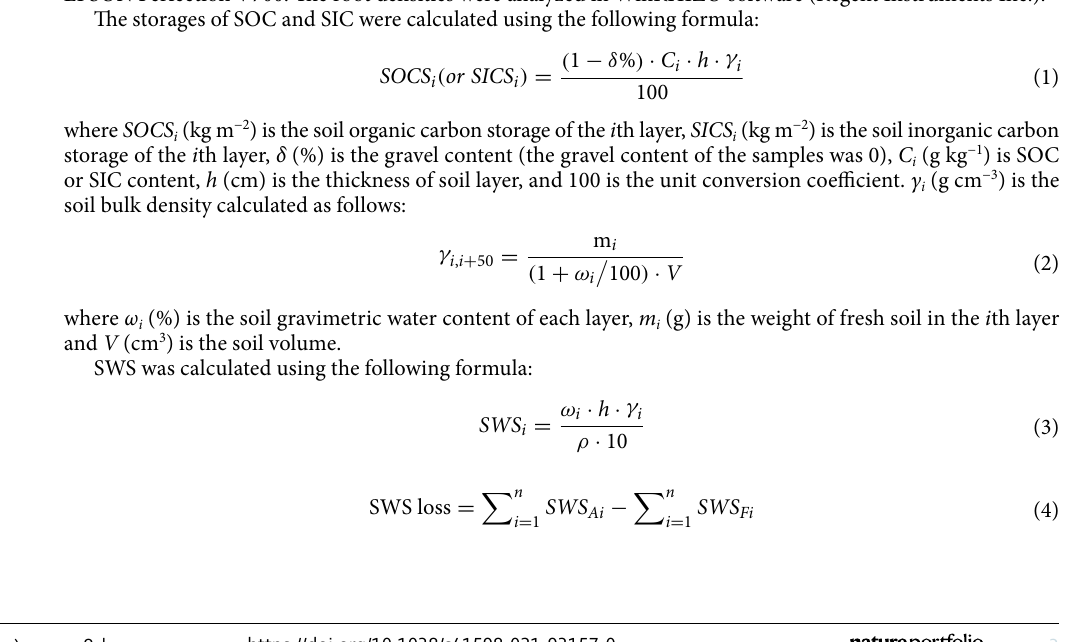
Fig S1. The roots were also collected using a root auger (diameter 6 cm) layer by layer (20 cm interval), washed with tap water to remove soil particles, placed in a plexiglass tray with 1 cm water, and then scanned using the